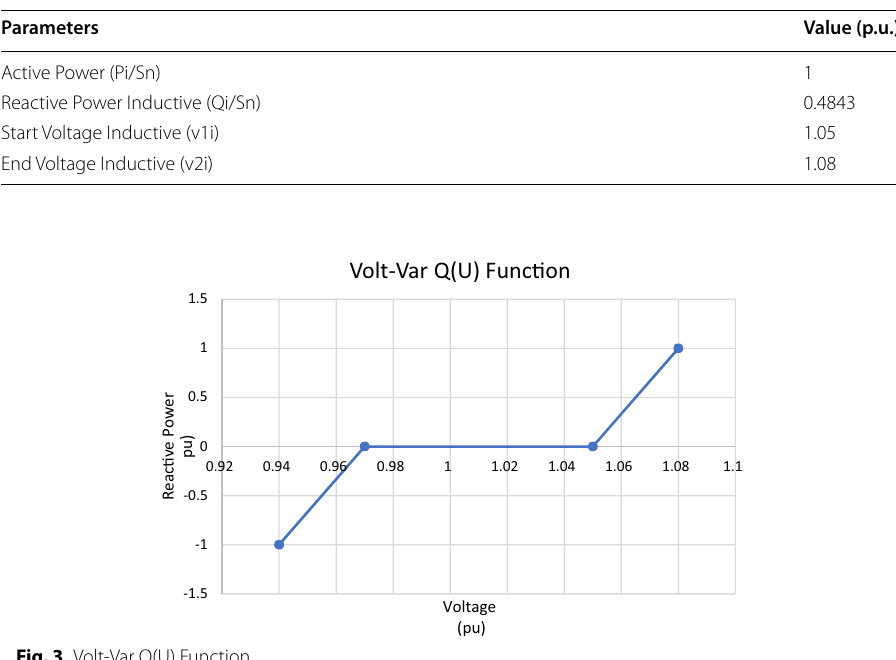
Fig. 3 Volt-Var Q(U)